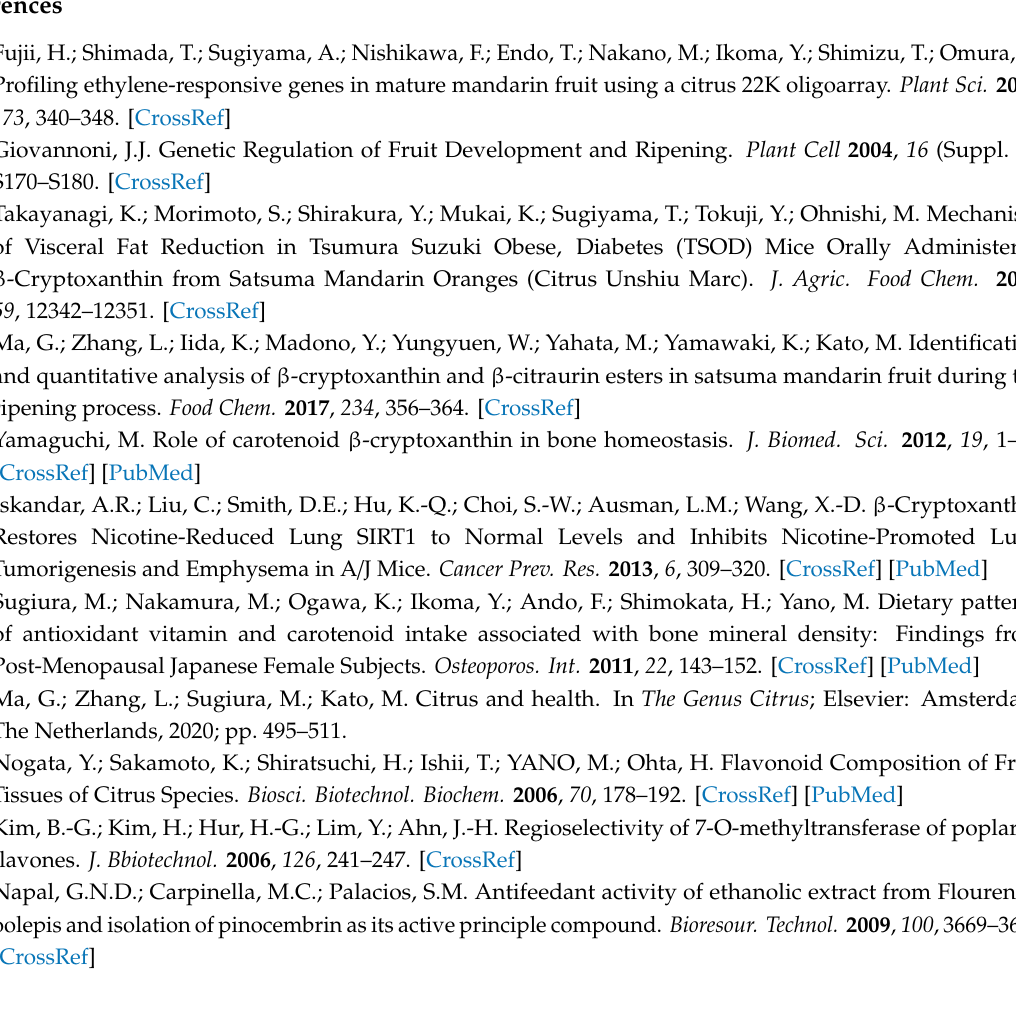
Table S1: Primer sequences and TaqMan MGB Probes used for the TaqMan real-time RT-PCR of the genes related to plant hormones, flavonoid and carotenoid metabolisms., Table S2: Representative salicylic acid responsive genes showing di ff erential expression ( > 2-fold) between salicylic acid and control treatments (salicylic acid / control ratio). Table S3: Representative methyl jasmonate responsive genes showing di ff erential expression ( > 2-fold) between methyl jasmonate and control treatments (methyl jasmonate / control ratio). Figure S1: Chromatograms in the flavonoid and carotenoid in the juice sacs of citrus fruit in